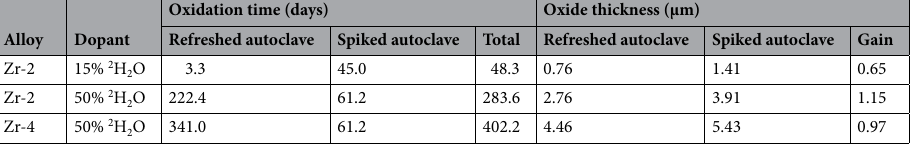
Table 2. Samples produced for this study showing the enrichment level of the water, oxidation time and oxide thickness.